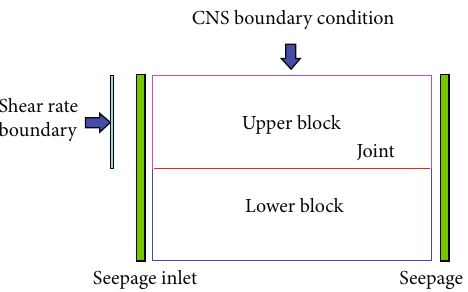
Figure 18: Shear- fl ow coupling numerical experimental